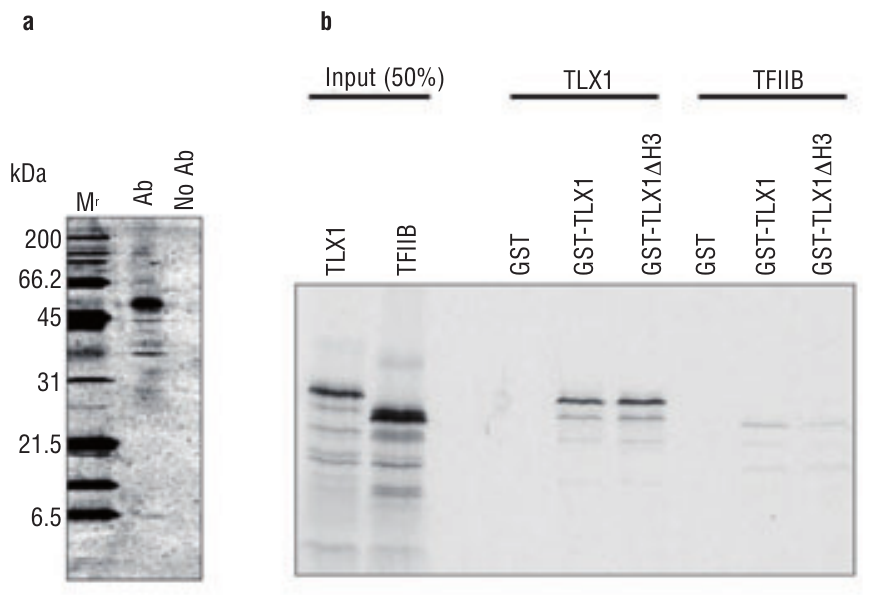
Table 1. Proteins identified by immunoprecipitation and peptide mass fingerprinting.